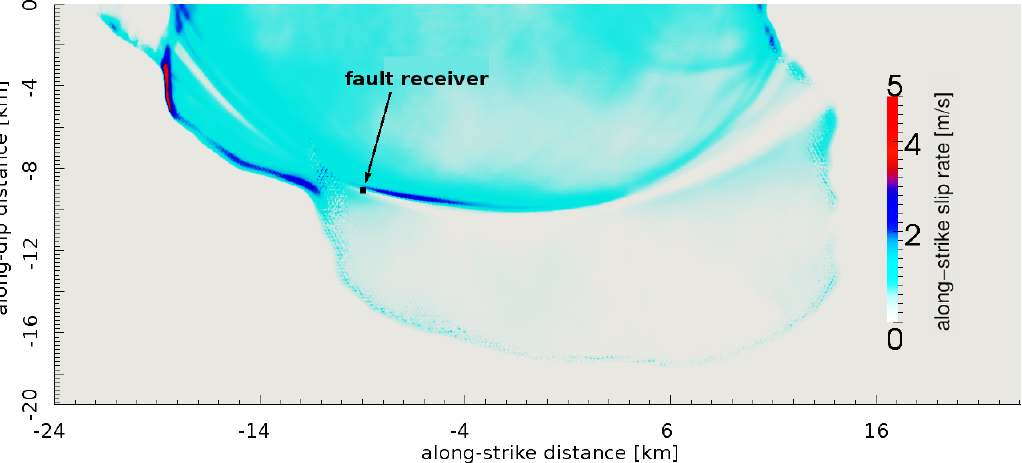
Fig. 7. Along-strike slip rate (in ms − 1 ) for TPV17 at t = 5 . 5s; the time at which the interface wave that originated at the free surface approaches the fault location indicated by an arrow and shown in Fig. 5. The elliptical shape of the interface wave front is clearly visible, which consists of a healing phase followed by a high slip rate front.